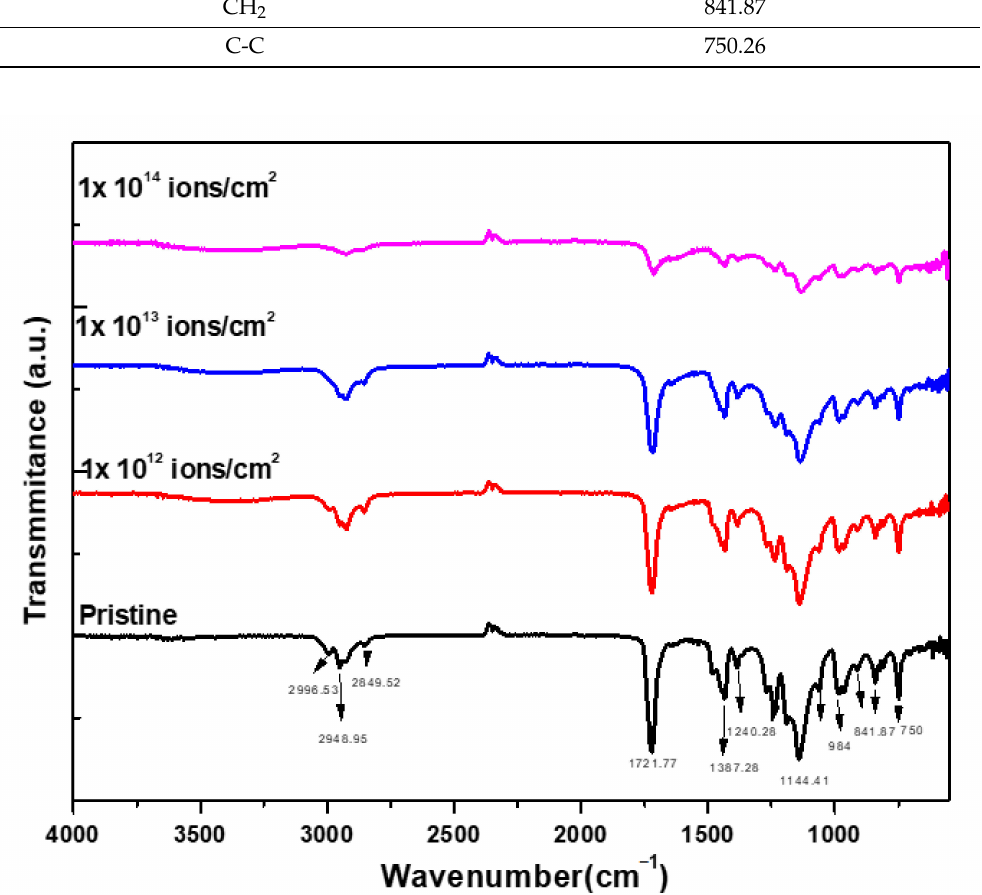
Figure 5. FTIR spectrum of Cu + implanted PMMA for different